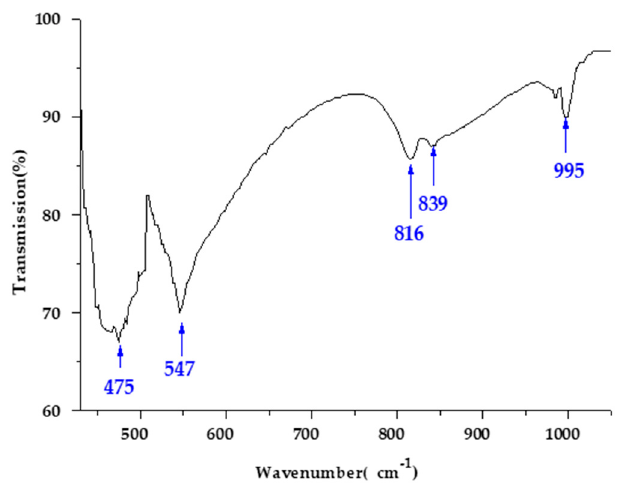
Figure 5. Fourier-transform infrared spectroscopy (FT-IR) spectrum of Mo oxide at the condensation temperature of 200 °C.